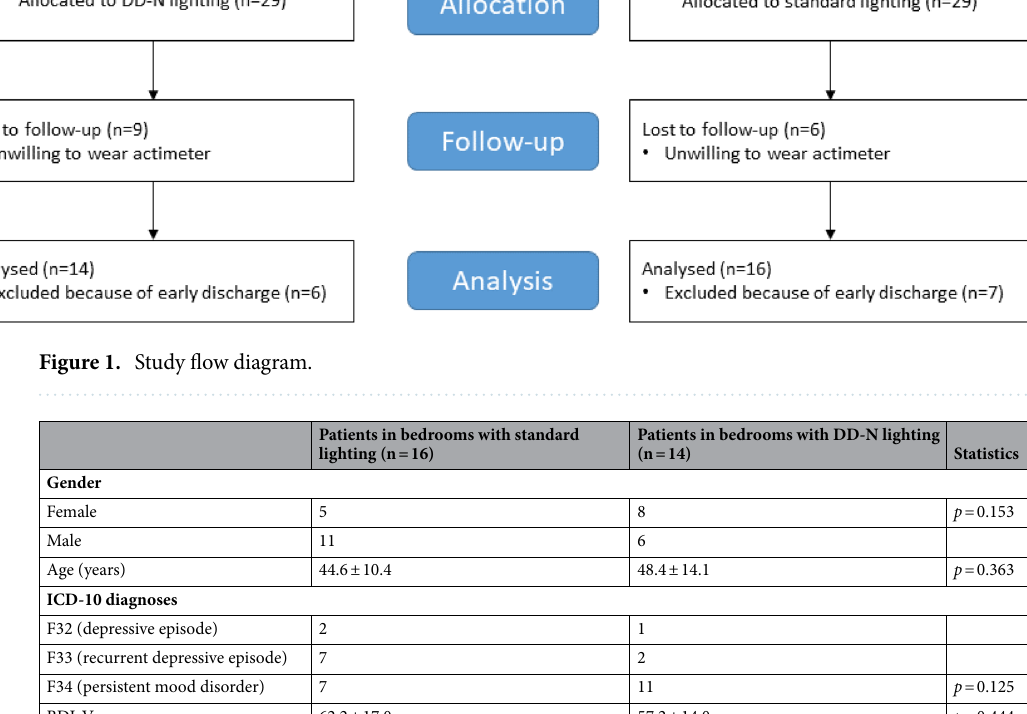
Table 1. Description of study sample. Values are either shown as mean ± standard deviation or count data. BDI‑V Beck Depression Inventory, ICD‑10 International Classification of Diseases 29 .